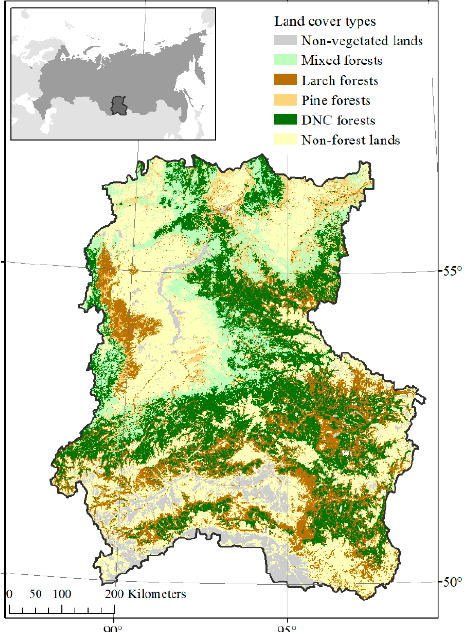
Figure 1. Study area. Land cover types are shown in colors.